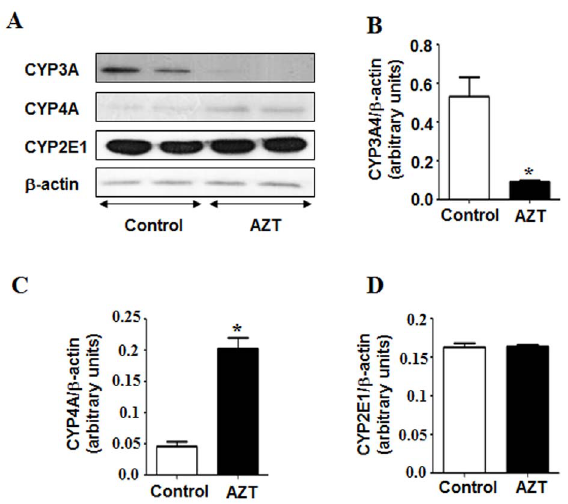
Figure 2. Effect of AZT on the levels of CYP3A4, CYP4A and CYP2E1 proteins. (A) Equal amounts of whole liver homogenates (50 m g/lane) from both groups were used to evaluate the levels of CYP3A4, CYP4A and CYP2E1 (upper, middle and lower panel), respectively. (B, C, D) The densities of each immunoreactive band were normalized to that of b -actin as the loading control. *Significantly different from the control group. Data indicate mean 6 SE, p , 0.05. All experiments have been conducted three times.